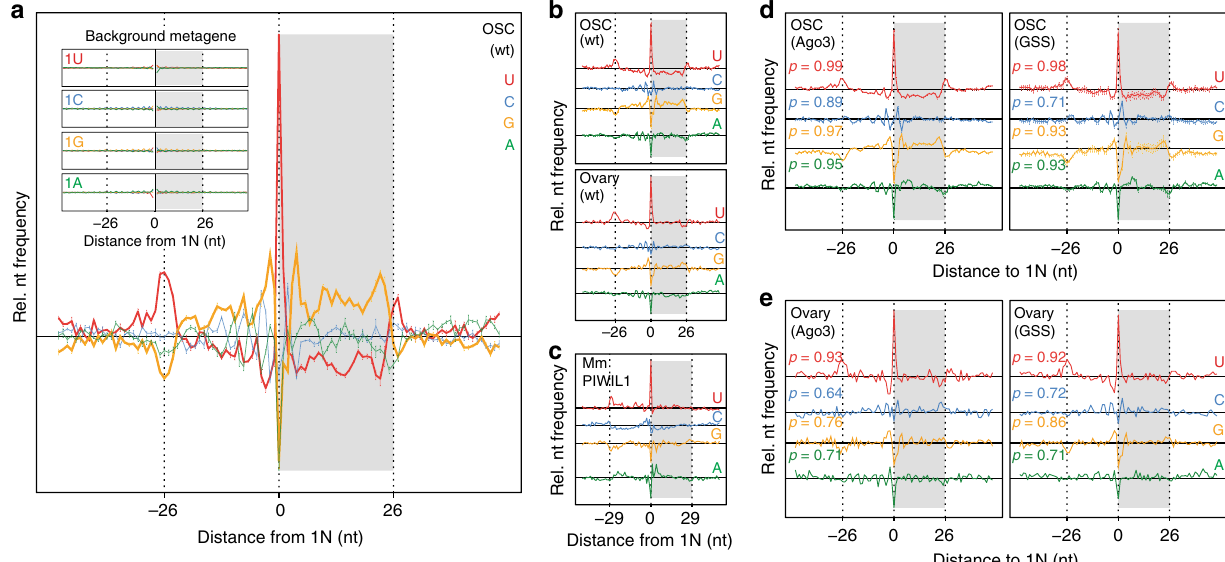
Fig. 3 Preferences during piRNA biogenesis establish sequence restrictions. a Patterns of nucleotide frequencies within a 101 nt window surrounding the 5 ′ end of Piwi-piRNAs (position 0) in OSC. Data represent the mean of three biological replicates ( n = 3) and standard deviations are indicated. Nucleotide 1 – 26 of the observed piRNAs are indicated by a gray box. The insert illustrates the background model with all possible 1U, 1C, 1G, or 1A starting piRNAs from Piwi-piRNA clusters. b Patterns of nucleotide frequencies for all four nucleotides of Piwi-piRNAs from OSC, fl y ovaries, and c mouse Piwil1-associated piRNAs. Patterns of nucleotide frequencies of piRNAs associated with Piwi-SL mutants in OSC ( n = 3) ( d ), and fl y ovaries ( n = 1) ( e ). Correlation coef fi cient (Pearson) compared to Piwi-SL-wt are indicated ( d , e ). [ M = 1: Only unique mapping reads are considered to ensure unambiguous genomic coordinates. (See also Supplementary Fig. 3 and Supplementary Data